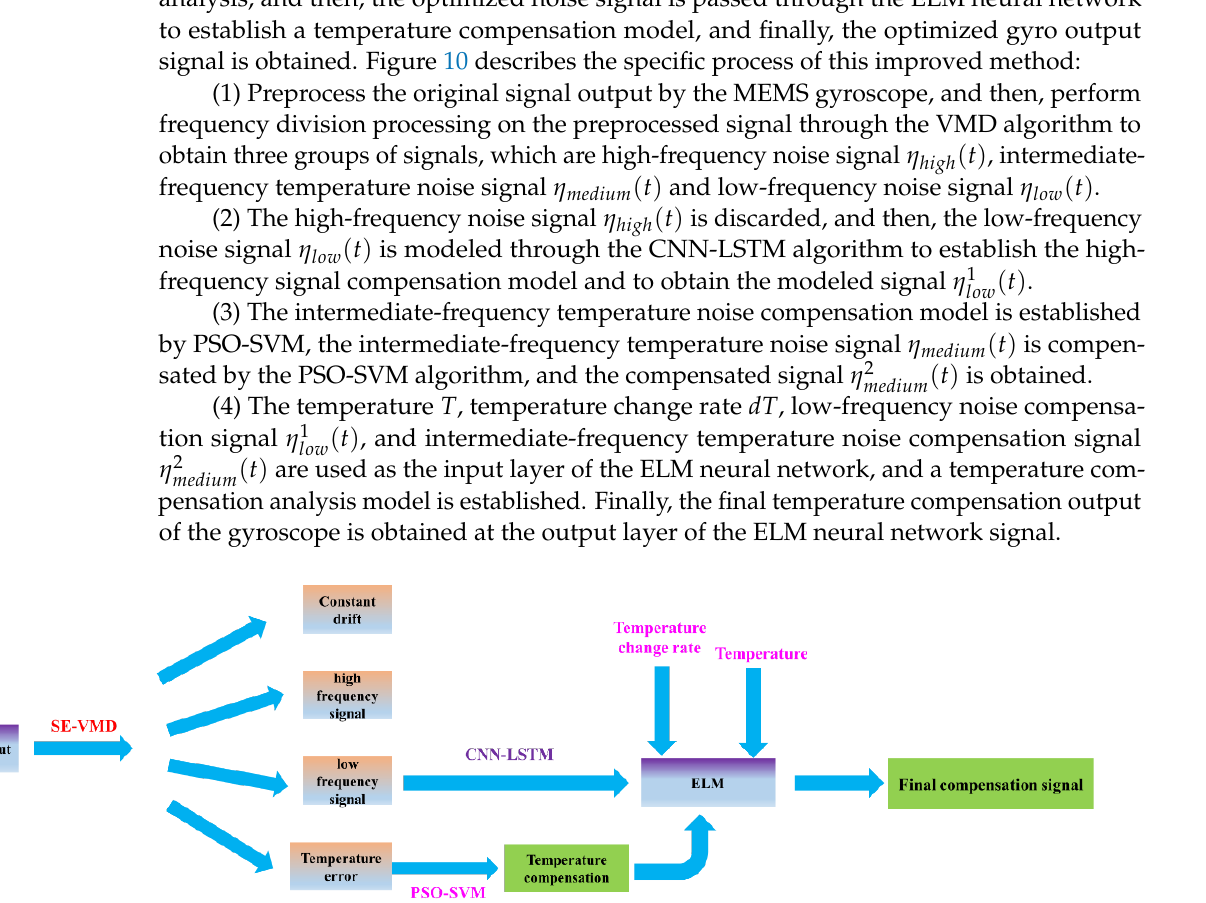
Figure 10. The specific process of the improved method.